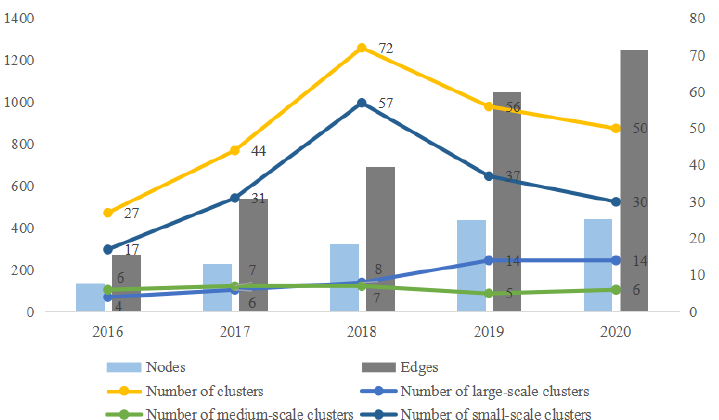
Figure 4. Modularization distribution of the digital construction industry (2016–2020).